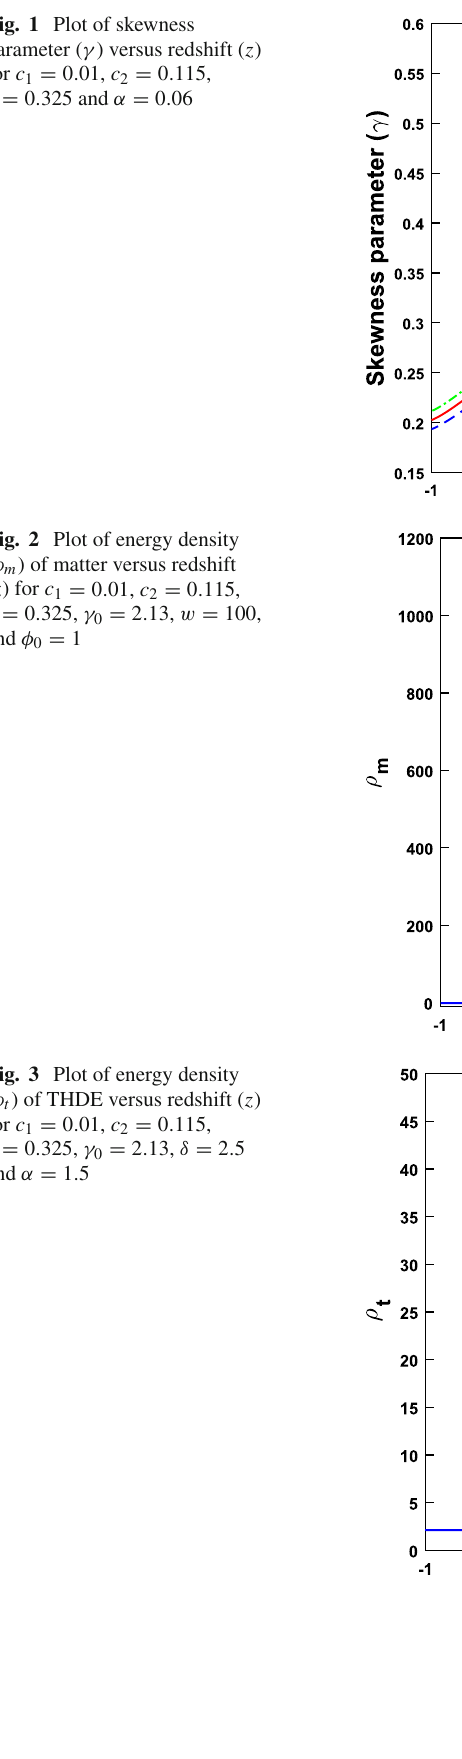
Fig. 1 Plot of skewness parameter ( γ ) versus redshift ( z ) for c 1 = 0 . 01, c 2 = 0 . 115, k = 0 . 325 and α = 0 . 06